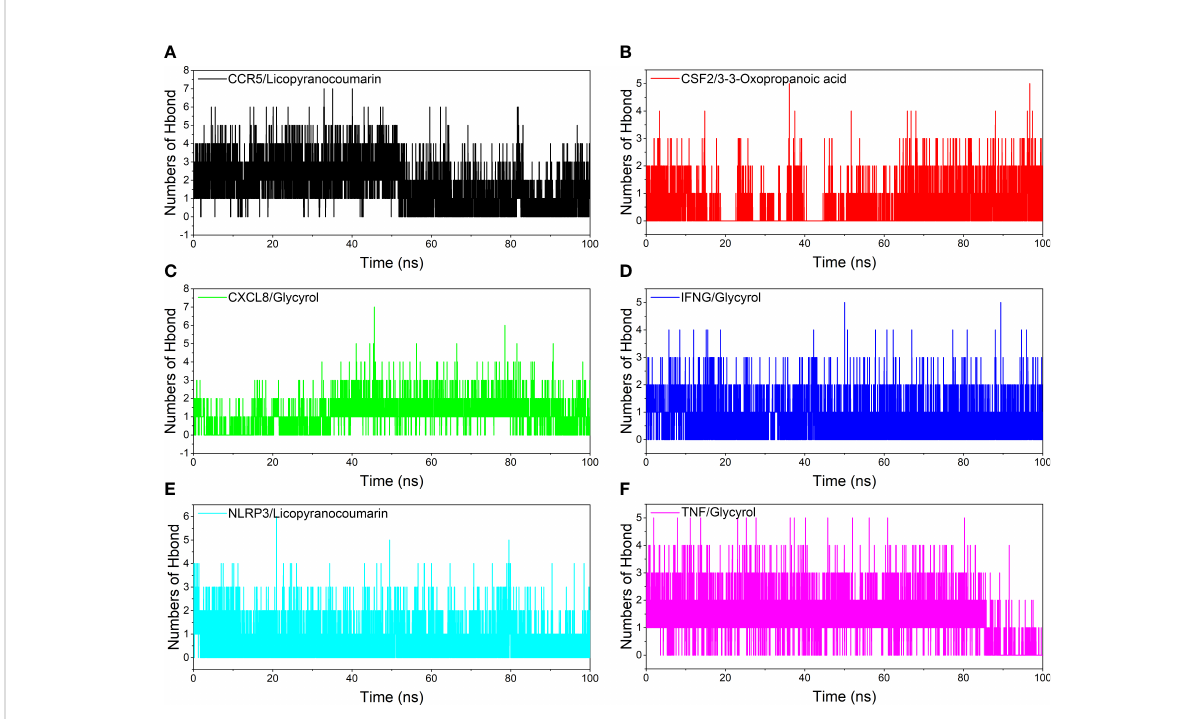
FIGURE 8 Analysis of hydrogen bonds. (A) CCR5/Licopyranocoumarin, (B) CSF2/3-3-Oxopropanoic acid, (C) CXCL8/Glycyrol, (D) IFNG/Glycyrol,